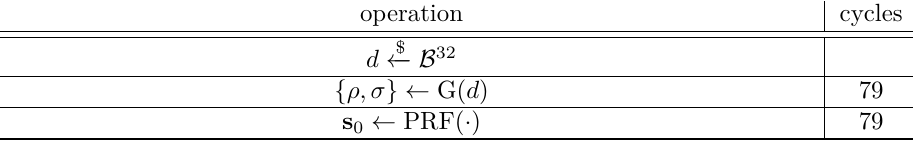
Table 8: Detailed procedures in server side and corresponding cycle counts in implementing Kyber.CCAKEM protocol when k